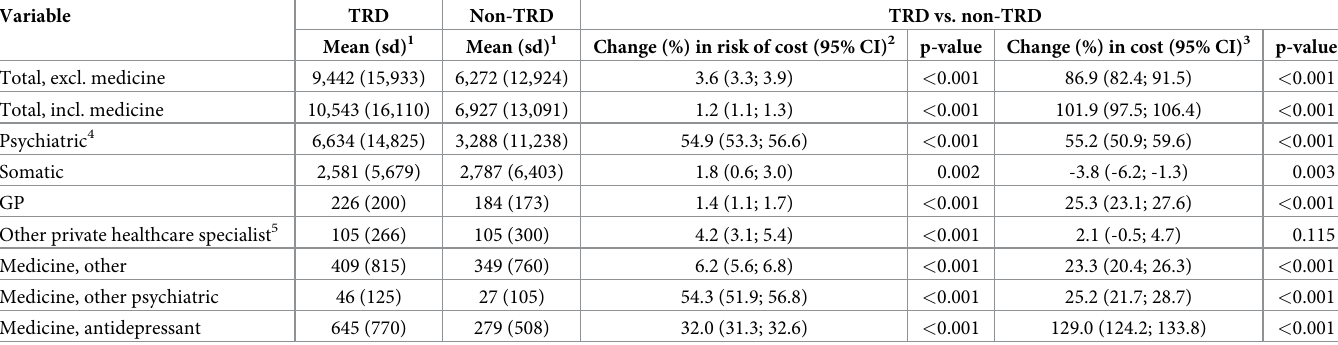
Table 3. Average healthcare resource utilization costs (EUR) comparing TRD patients with non-TRD patients in the matched